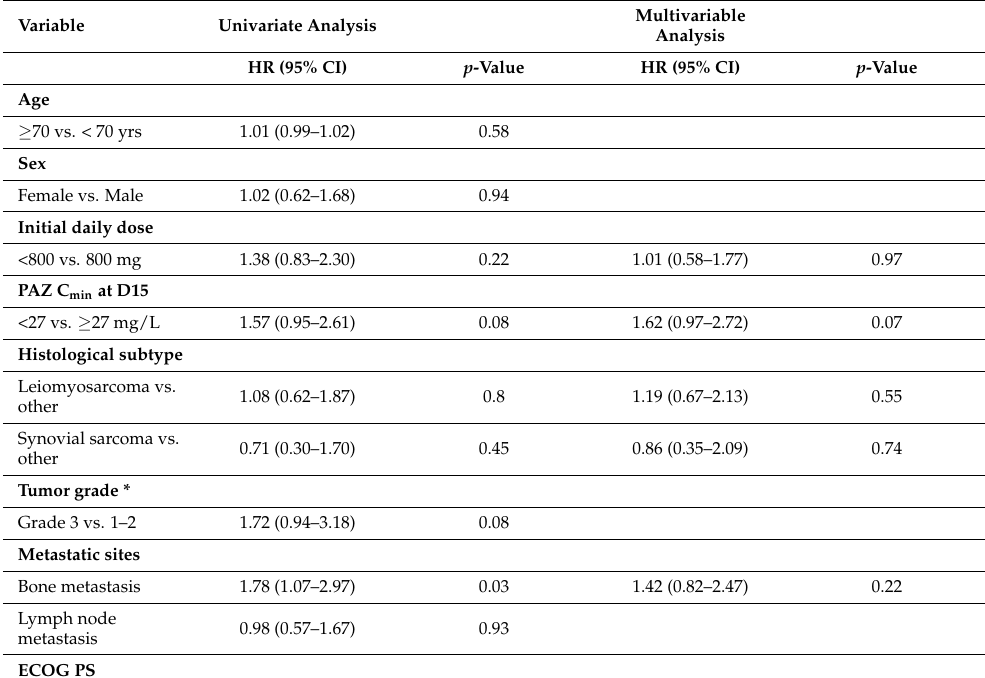
Figure 3. Kaplan–Meier analysis for OS according to pazopanib concentration at D15 (n = 95). Table 3. Univariate and multivariable Cox proportional hazard analysis for OS (n = 95).